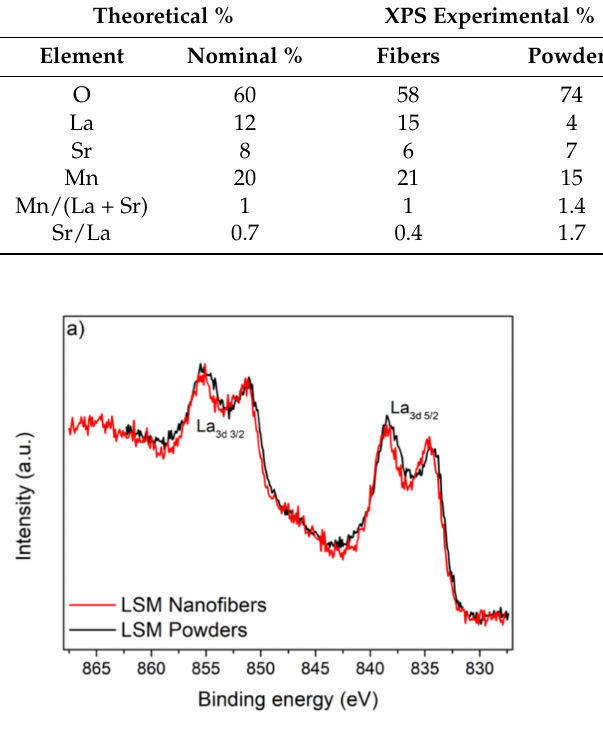
Figure 3. XRD results. The LSM reference pattern is shown in blue. Other experimental LSM patterns are as follows: powders after thermal treatment in black; electrospun nanofibers after thermal treatment in red; nanofibers after H 2 -TPR performed up to 550 ◦ C in grey and 900 ◦ C in pink; powders after reduction in H 2 up to 900 ◦ C in orange; and nanofibers after CH 4 oxidation up to 800 ◦ C in green. Blue triangles refer to LSM peaks, while red circles denote MnO phase. All patterns are normalized with respect to their maximum values. Table 1. XPS and EDX quantitative results of the atomic composition of LSM fibers and nanofibers. For better comprehension, nominal values are reported as well.